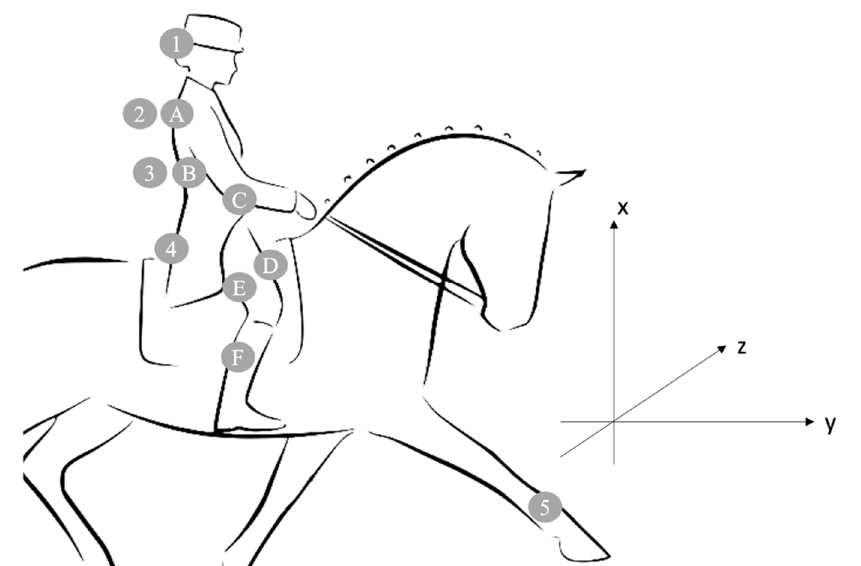
Figure 1. Placement and orientation of the inertial measuring units (IMU) and surface electromyo- graphical (sEMG) sensors. (1) Helmet IMU, (2) T4 IMU, (3) L1 IMU, (4) cantle of the saddle IMU, (5) horse fore limb IMU, (A) erector spinae sEMG, (B) multifidus sEMG, (C) external oblique sEMG, (D) vastus lateralis sEMG, (E) biceps femoris sEMG, (F) gastrocnemius lateralis. Note that all sEMG sensors were placed contralaterally.